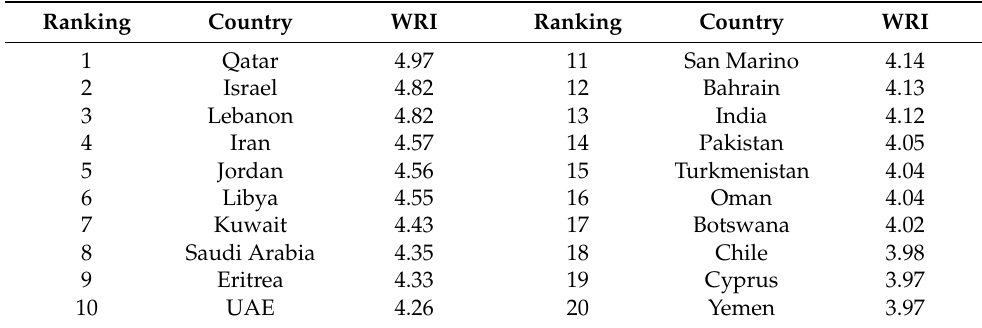
Table 1. Ranking of the top 20 countries with the highest hydric stress, according to the water risk index